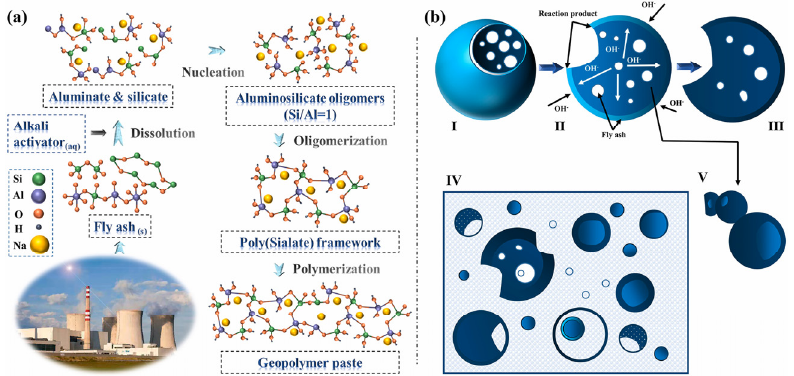
Figure 5. Reaction mechanism of CFA-based geopolymers [89]. ( a ) Macro mechanism model of CFA alkali activation reaction; ( b ) descriptive model of the alkali activation of CFA according to one or several particle